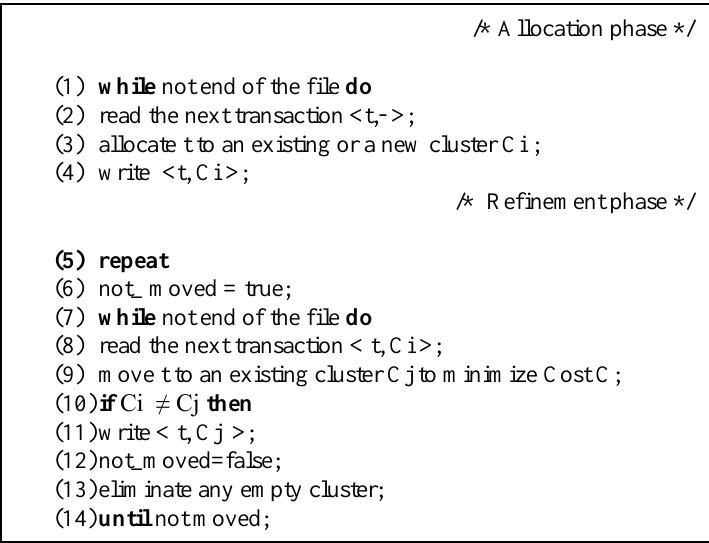
Figure 2: The overview of the clustering algorithm Fig. 2. Overview of clustering